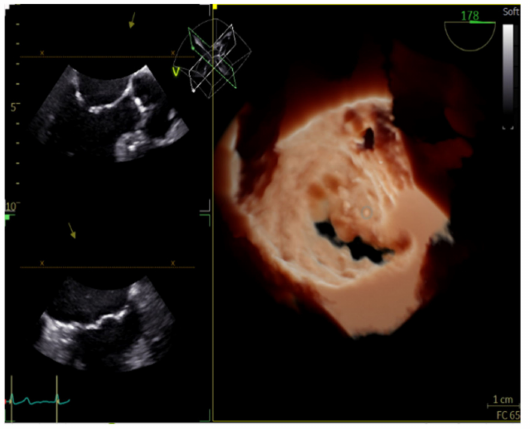
Figure 4. Three-dimensional image of the mitral valve (Surgeon’s view).